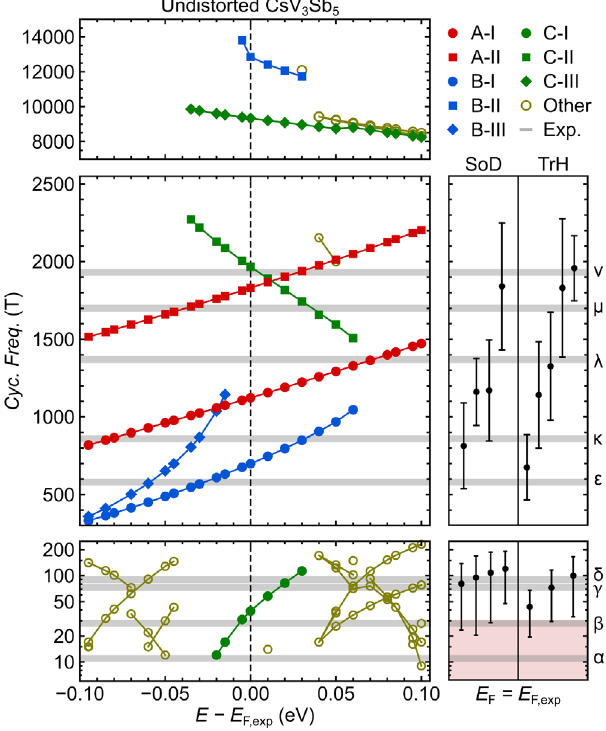
FIG. 9. Frequencies extracted as a function of Fermi level in undistorted CsV 3 Sb 5 , which allow us to directly compare the experimental SdH data (gray bars) with the DFT models. The undistorted oscillation frequencies are shown as a function of Fermi level (left). Colored frequencies have been grouped by the pocket and orbit of the origin. A conservative numerical estimate for the supercell orbits for the SoD and TrH structures is shown E (left) at E F; exp . While five mid-frequency orbits are indeed F ¼ 0 . 1 eV, no singular choice of E expected in the range E F (cid:3) F produces complete agreement with experiment. However, the TrH distortion introduces a new high-frequency V d orbit, similar to B-III, which provides a consistent hypothesis. The DFT resolution limit (pink shaded) indicates the frequency range below which we cannot accurately resolve closed